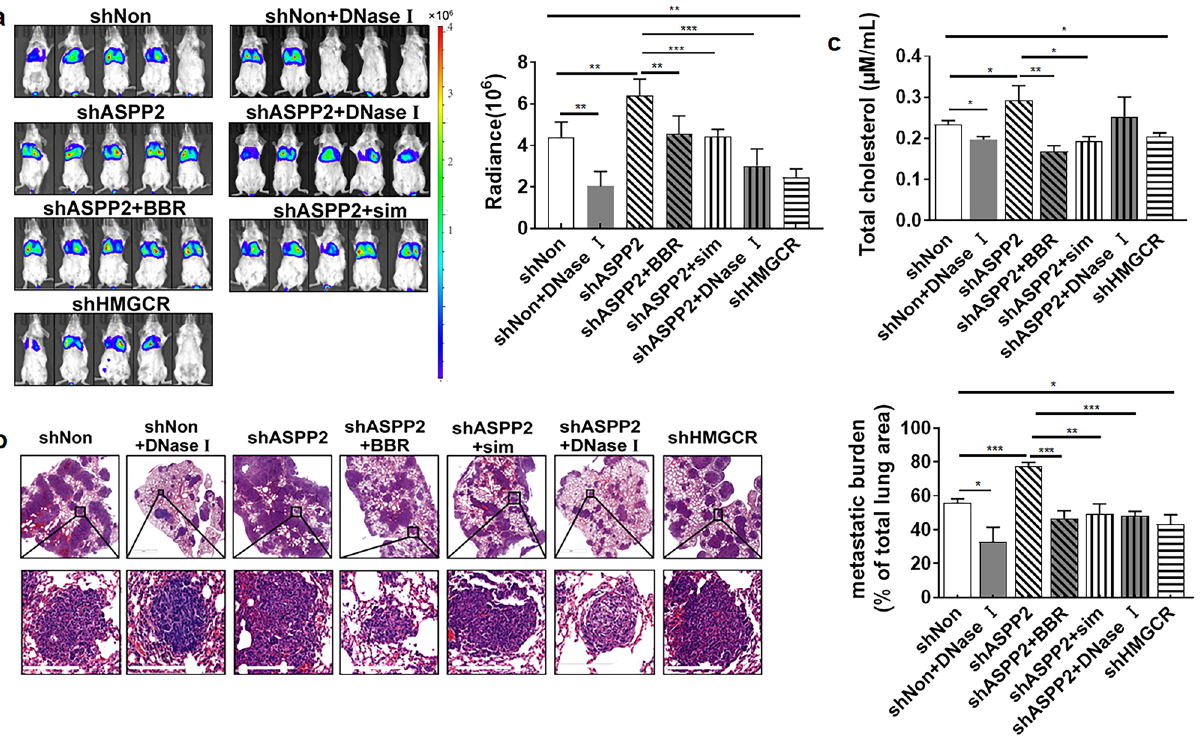
Figure 4. Inhibition of cholesterol biosynthesis suppresses lung metastasis of breast cancer in LPS-stimulated mice. ( a ) Female BALB/c mice were intraperitoneally injected with LPS for 6 h before luciferase expressing 4T1 (1 × 10 6 ) cells were injected through the tail vein. Inducible shRNA-luc expressing 4T1 cells were monitored by BLI every 3 days. Simvastatin, BBR or DNase I treatment was initiated after randomization on day 5 (n = 5 mice per group; means ± SD). Representative BLI images at day 25. The densities of BLI images were calculated and statically analyzed. ( b ) Representative H&E images of the lung metastases in LPS-stimulated mouse model. (n = 10 each). Lung metastatic burdens were assessed by comparing metastatic area to total lung area. Scare bar: 200 µm. ( c ) Mice are bled from the retro-orbital venous plexus on day 24, and serums are collected. Cholesterol levels are determined and statically analyzed. * P < 0.05; ** P < 0.01; *** P <